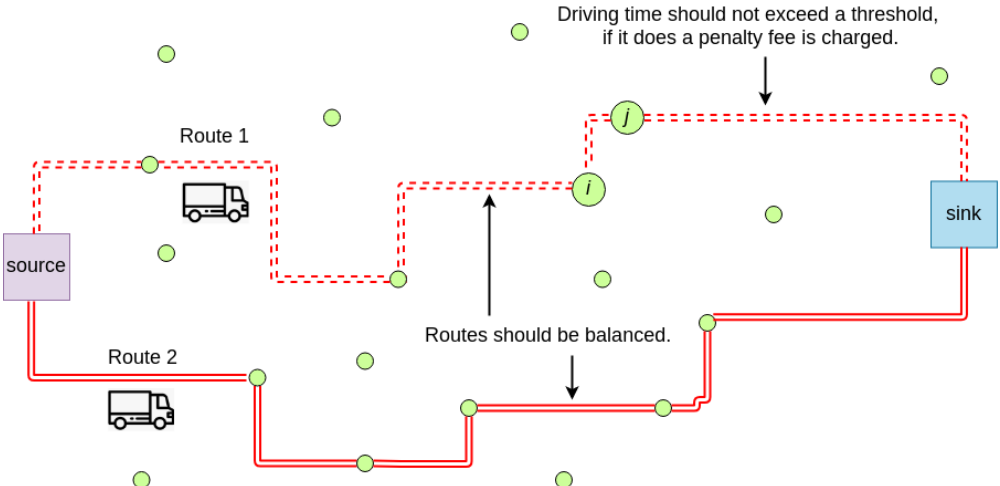
Figure 1. The stochastic and non-smooth team orienteering problem with soft constraints (source: own